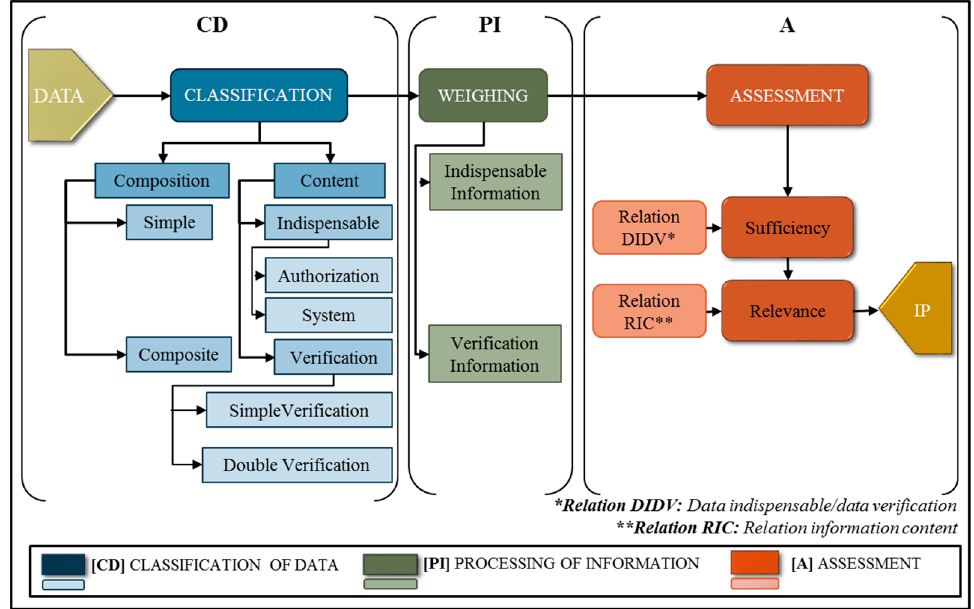
Figure 1. The classification of data, processing data into information, and assessment (CD-PI-A) model.